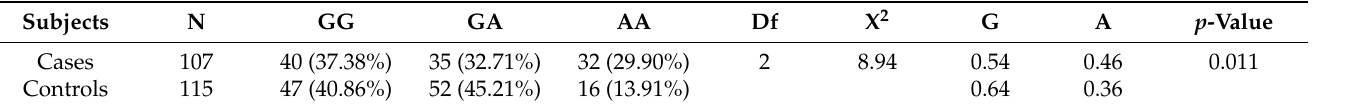
Table 3. Association of Krüppel-like factor 14 rs972283 G > A gene variation in PCOS cases and controls.